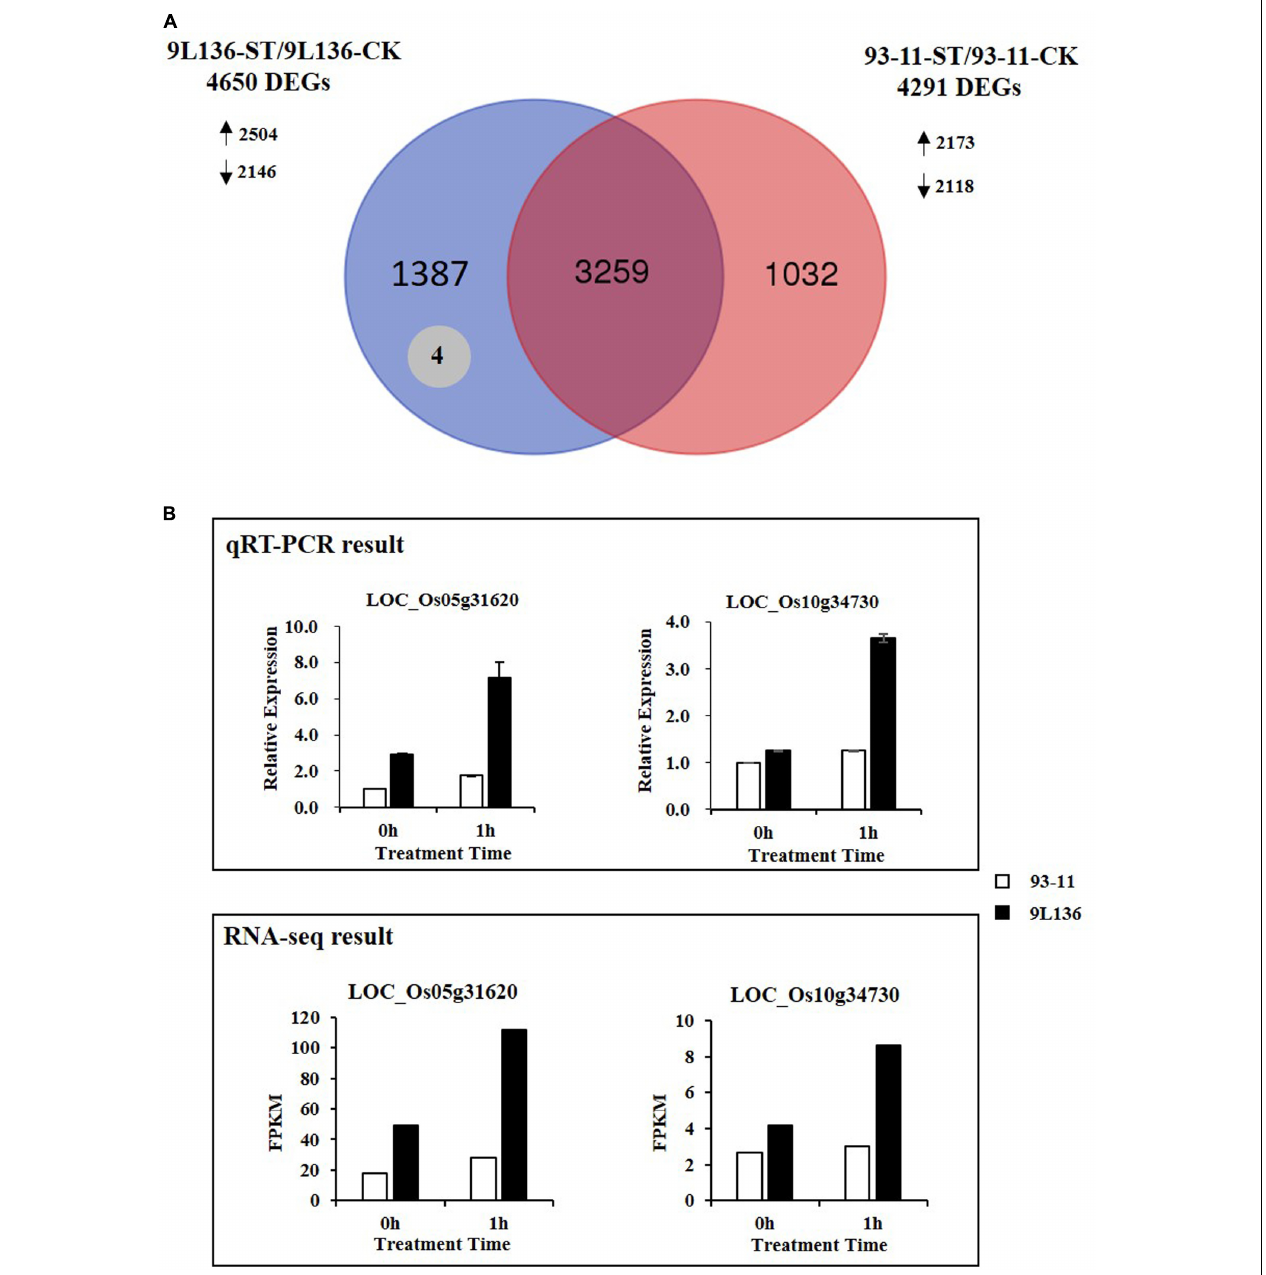
FIGURE 4 | Identification of candidate genes related to salt tolerance from wild rice. (A) Venn diagram analysis for RNA-seq data showing differentially expressed genes between 9L136-ST/9L136-CK and 93-11-ST/93-11-CK. There were 1,391 genes showed differentially expressed only in 9L136-ST/9L136-CK but not in 93-11-ST/93-11-CK (A) , suggesting these genes should be specifically induced in introgression line 9L136. Among the 1,391 genes, four were co-localized with QTLs for salt tolerance (shown in gray circle). Arrows indicated the up-regulated ( ↑ ) and down-regulated ( ↓ ) genes. (B) Expression profiles of LOC_Os05g31620 and LOC_Os10g34730 detected by qRT-PCR and RNA-seq,